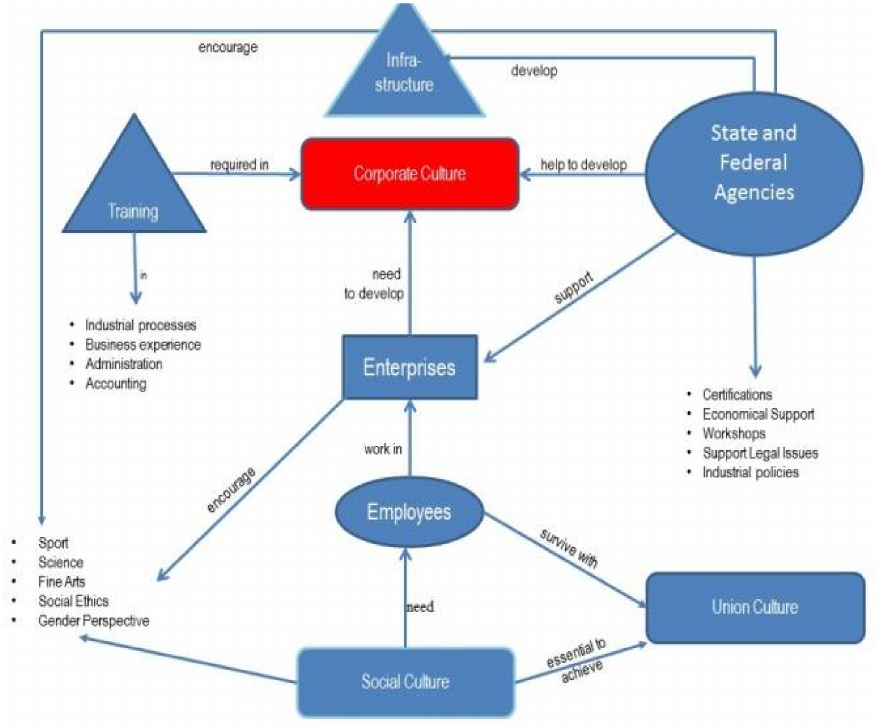
Figure 10. Integrative model enterprise–society–government. Source: Author’s own elaboration. Source: Author’s